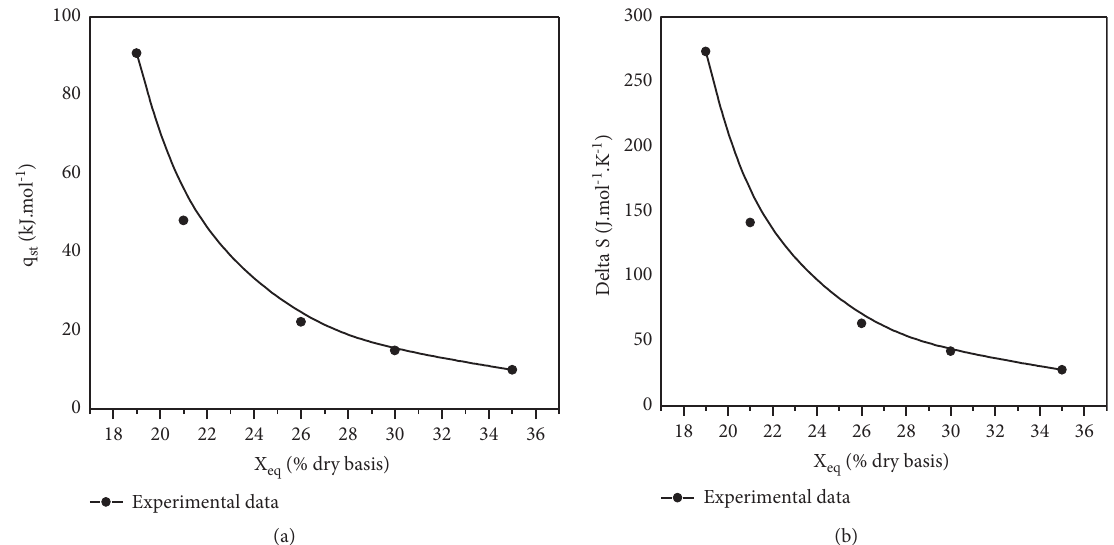
Figure 6: Relationships between equilibrium moisture content and (a) isosteric heat and (b) differential